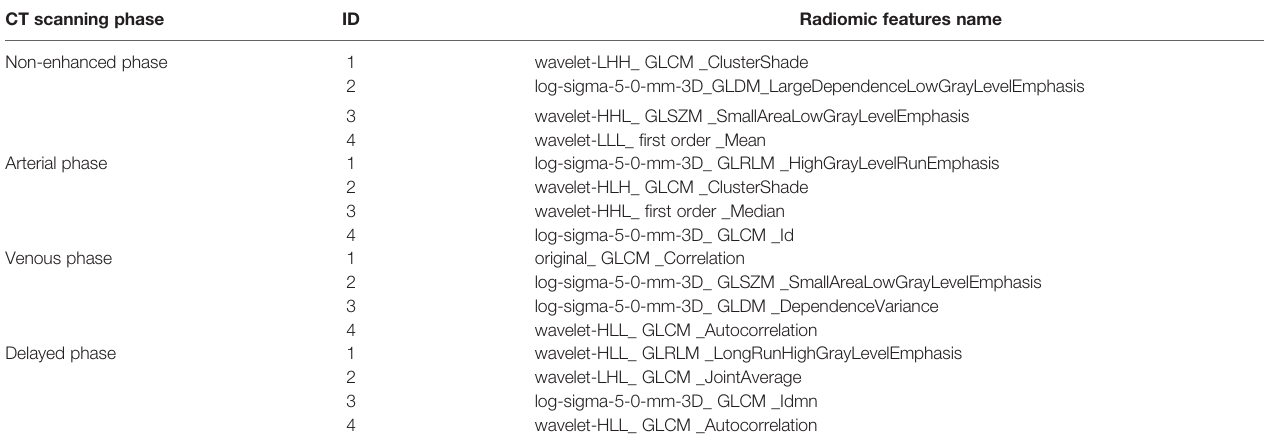
TABLE 1 | Radiomic features selection